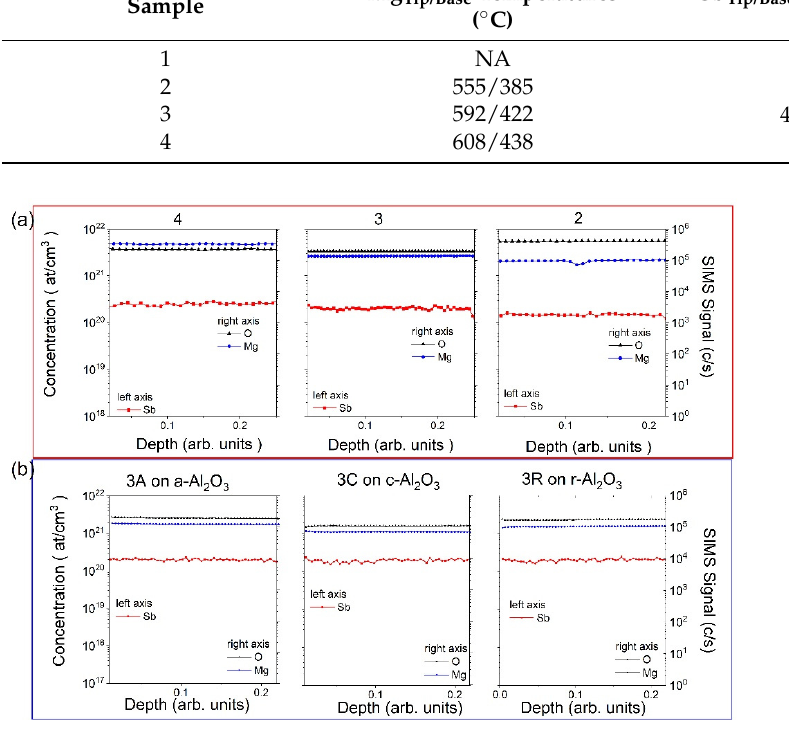
Figure 1. SIMS depth profiles for ( a ) a series of Zn 1 − x Mg x O samples with different concentration of Mg. Blue line corresponds to the Mg signal (right axis), red line refers to the Sb concentration obtained based on ion implantation standards (left axis); ( b ) a series of samples with the same concentration of Mg but grown on differently oriented sapphire substrates.